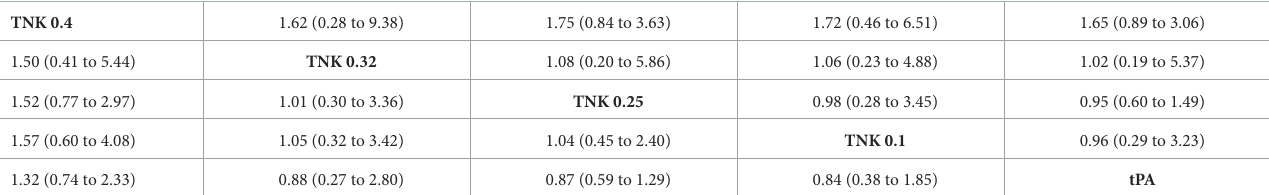
TABLE 2B Network meta-analysis of different treatments and functional outcomes—Mortality (lower part) and sICH (upper part)